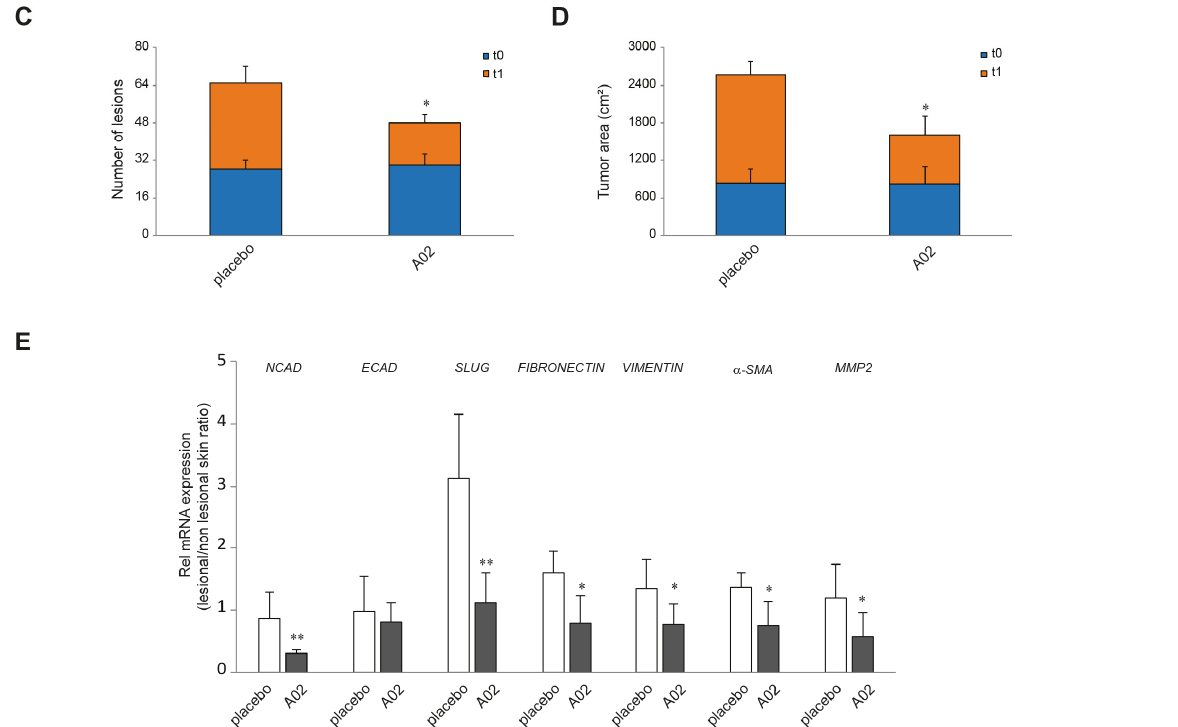
Figure 7. A02 impact on DMBA-TPA effects in vivo. ( A ) Luciferase activity in MITO-Luc mouse with induced papillomas. BLI of MITO-Luc mice before treatment (pre-imaging), after treatment with DMBA-TPA on the ventral abdomen (t0), and after 15 treatments with placebo or A02 (t1). Images were collected for 5 animals for each treatment, and a representative animal is shown. Photon emission from the lesions was measured as photons per second per square centimeter per steradian (photons/s/cm 2 /sr). ( B ) The graph illustrates BLI signal intensities relative to DMBA-TPA drug treatment control (t0) after 15 treatments with placebo or A02 (t1). Each bar represents the mean value ± SEM of five animals. The number of lesions ( C ) and tumor area (cm 2 ) ( D ) have been measured at t0 and t1 by automatically drawing the regions of interest upon BLI analysis. The graph represents the mean value ± SEM of five animals. ( E ) Real-time RT-PCR analysis of NCAD, ECAD, SLUG, FIBRONECTIN, VIMENTIN, α -SMA, and MMP2 in samples of mouse skin collected in lesional and nonlesional areas at the end of the 15 treatments with placebo or A02 (3 different mice per treatment group). All mRNA values were normalized against the expression of GAPDH and were expressed relative to nonlesional skin (* p < 0.05, ** p < 0.01 vs.